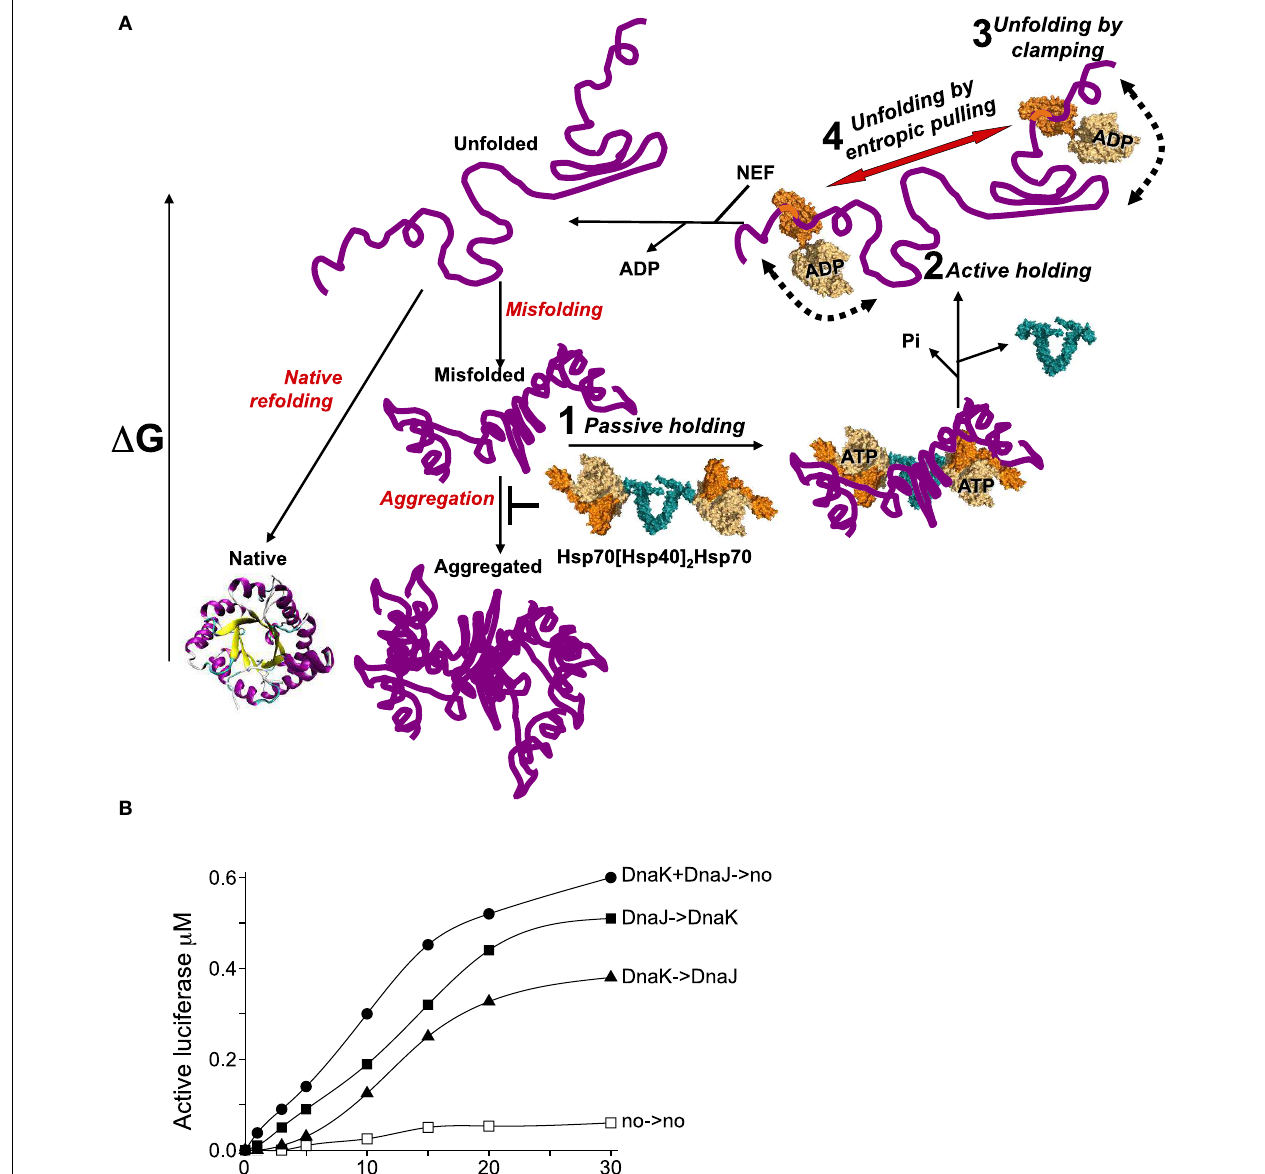
FIGURE 2 | The various modes of HSP70s action on their polypeptide substrates. (A) A nascent or a stress-unfolded polypeptide (upper left) with high free energy may readily fold to the native state (lower left) or misfold (middle center) and form stable aggregates with a low free energy. HSP70s, possibly pre-associated to HSP40 dimers, can spontaneously bind the misfolding species and thus passively prevent their aggregation, albeit rather inefficiently (step 1). ATP hydrolysis by HSP70 may actively lock the chaperone on the polypeptides and thus effectively prevent their aggregation (step 2). Further, ATP-hydrolysis can cause a forceful clamping motion of the lid toward the base of the PBD and apply an unfolding force that can cause local unfolding of misfolded segments in the substrate (step 3). The concomitant clamping of two distal HSP70s on the same misfolded polypeptide may further cause unfolding by entropic pulling of the intervening